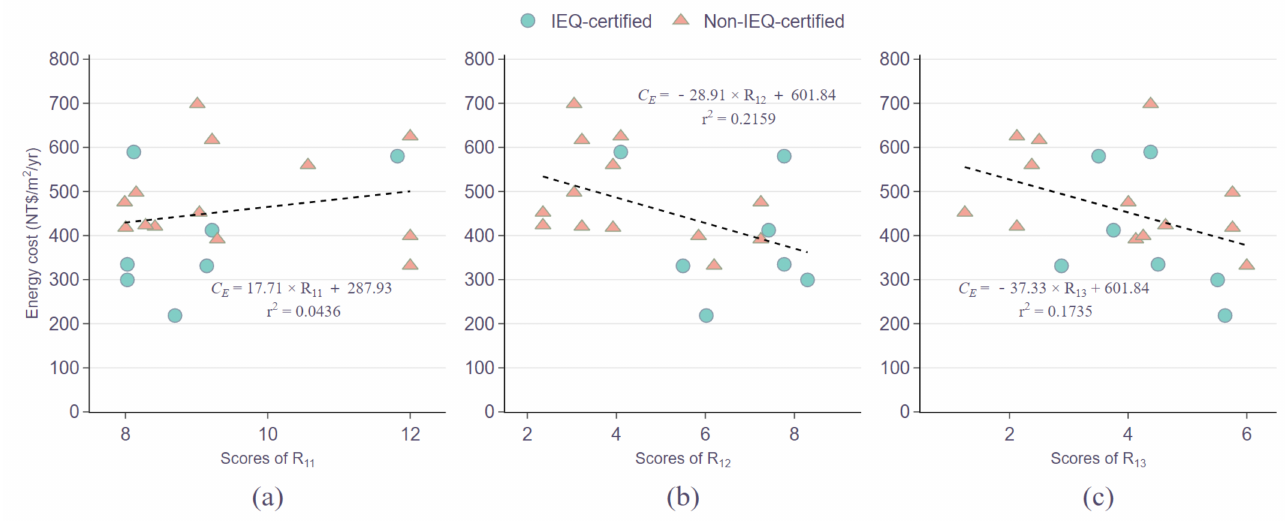
Figure 7. Analysis of the three aspects in R 1 scores. The relationships between building energy cost and ( a ) envelope thermal performance (R 11 ), ( b ) HVAC system efficiency, and ( c ) lighting system